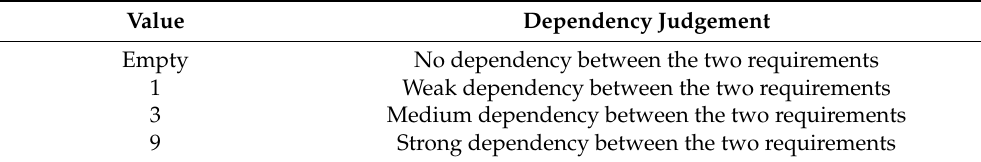
Table 2. Judgment values in the dependency matrix.